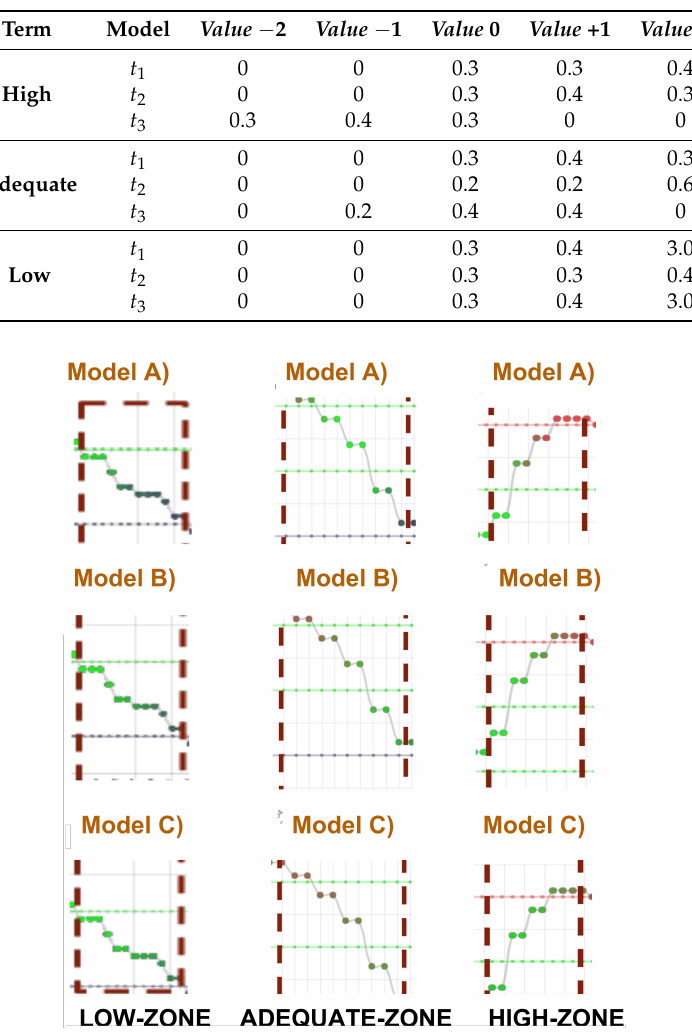
Figure 6. Impact of temporal windows on a case of prompt heart rate streams within the zones described by the linguistic terms { low , adequate , high } . Based on expert evaluation: Model A (short-term temporal window) suits in high zones detecting immediately critical HRs; Model B (middle-term temporal window) suits in adequate zone requiring a minimal permanence within; and Model B suits in the low zone without critical differences with regard to other